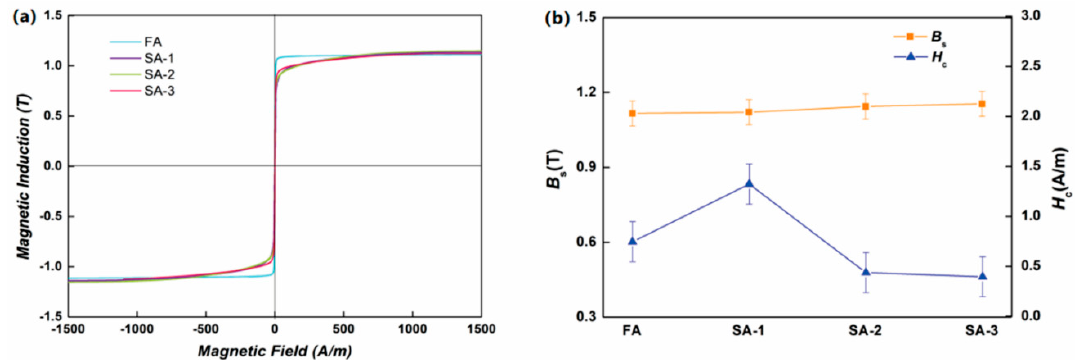
Figure 3. ( a ) DC (direct-current) hysteresis loops of Finemet-type magnetic cores annealed at 813K for 1h without and with radial stresses. ( b ) The values of B s and H c for different samples.